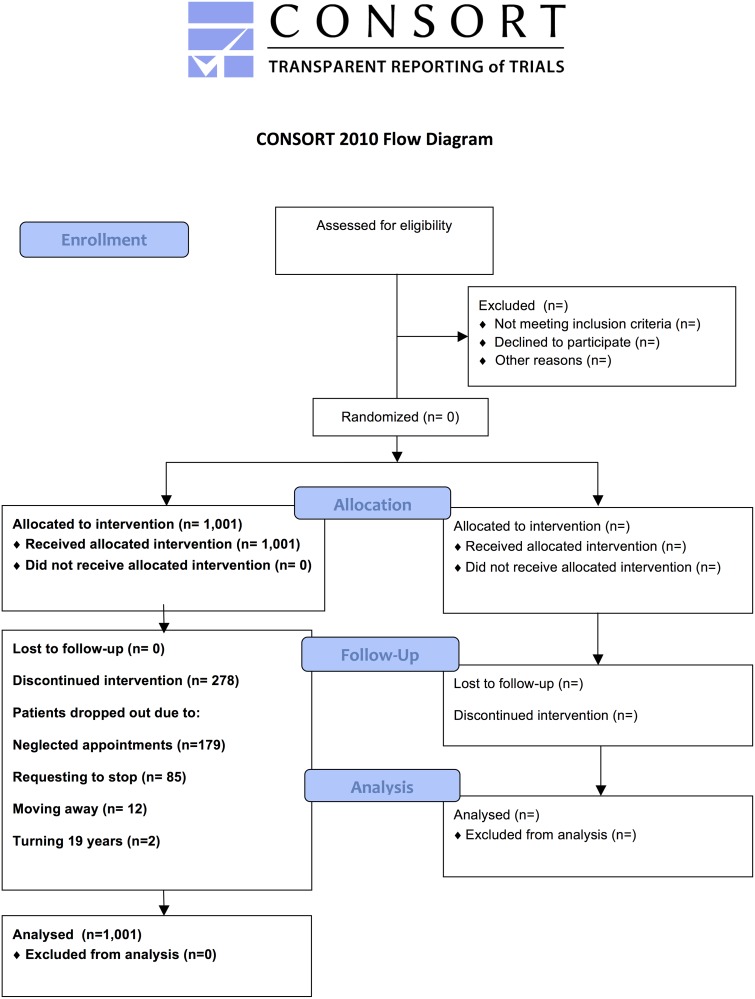
CONSORT diagram.